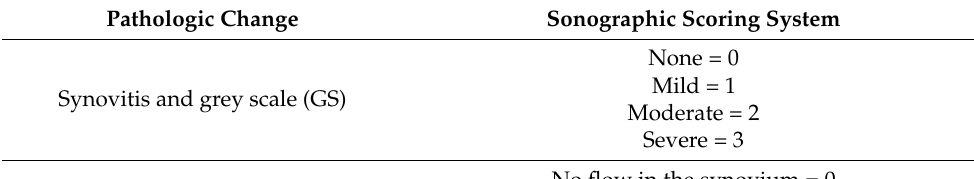
Table 2. Ultrasound imaging: synovial, Power Doppler and bone